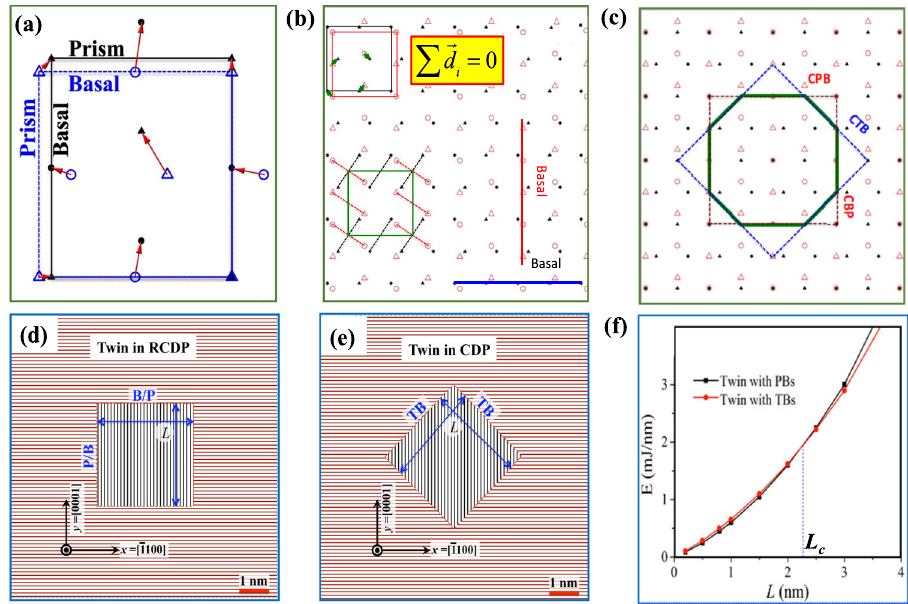
Fig. 5 Pure-shuf fl e nucleation mechanisms. a Two unit cells with a 90° rotation showing lattice mismatch. The blue dashed square and the black square indicate the unit cell. The circles and the triangles represent the positions of atoms and the red arrows indicate the shuf fl e directions. b Strained coherent dichromatic complex associated with the 90° rotation of two crystals. The green rectangle represents the coherent lattice, and the red and black rectangles represent the two crystals. The green arrows indicate the shuf fl e vectors and their summation is equal to zero. Both matrix and embryo have been equally strained to form coherent lattice and complex structures. c The modi fi ed strained coherent dichromatic complex by overlapping one set of atom sites, showing possible boundaries associated with a twin nucleus. CTB represents a coherent twin boundary, CBP represents a coherent basal-prismatic (BP) boundary, and CPB represents a coherent prismatic-basal (PB) boundary. The CPB or CBP deviates 1.9 degrees from the zero-stress CTB. d , e Schematics of two twin nuclei with various twin boundaries. CDP indicates coherent dichromatic pattern and RCDP indicates rotation coherent dichromatic pattern. f variation in mechanical work as a function of the twin